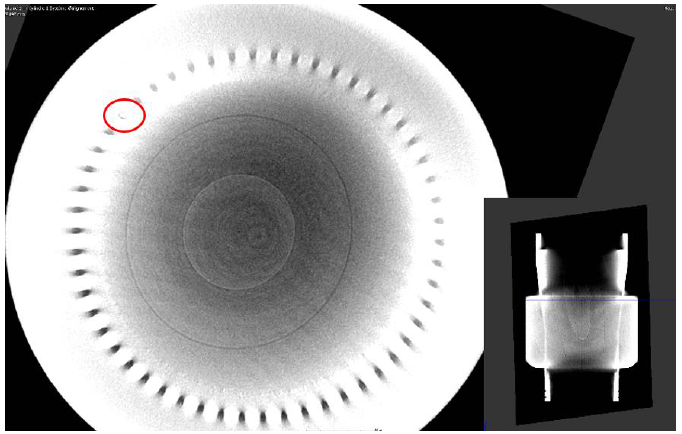
Figure 5. Tomography image of the copper cavity; the red circle evidences the plugged channels.